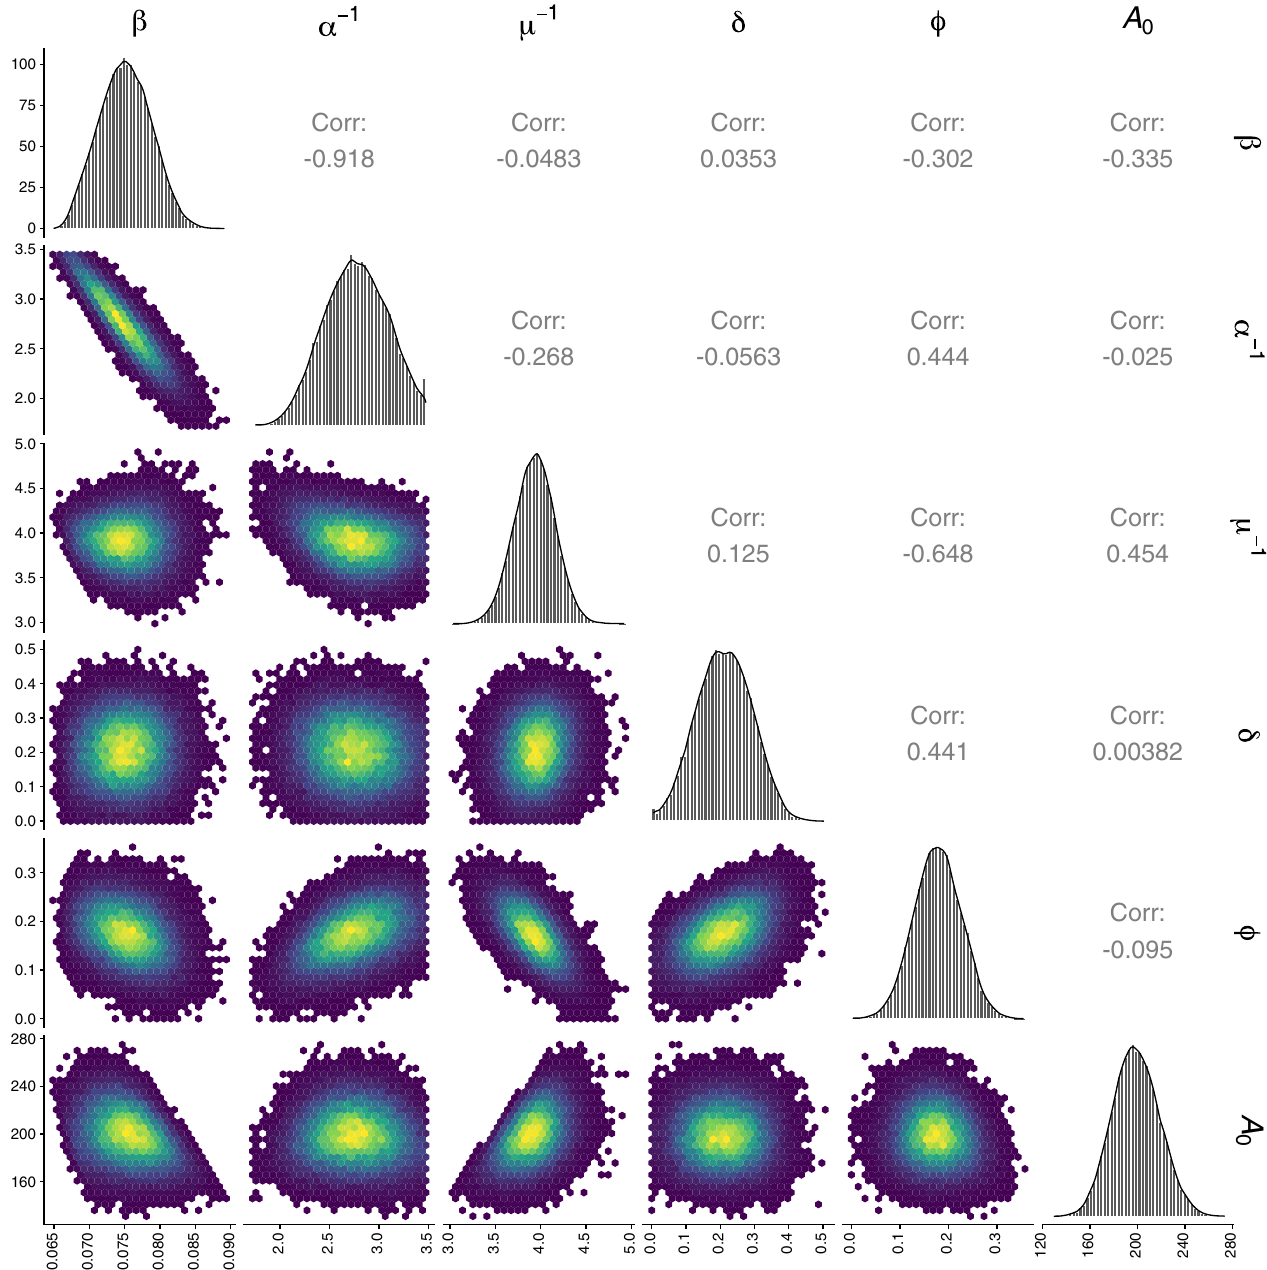
FIG. 7. Calibration analysis. The diagonal of the table contains the posterior distributions for the parameters obtained after model calibration. The lower triangular part shows the scatter plot for every pairwise combination of parameters present in the posterior parameter space, whereas the upper triangular one represent the entries of the covariance matrix for the parameters involved in the